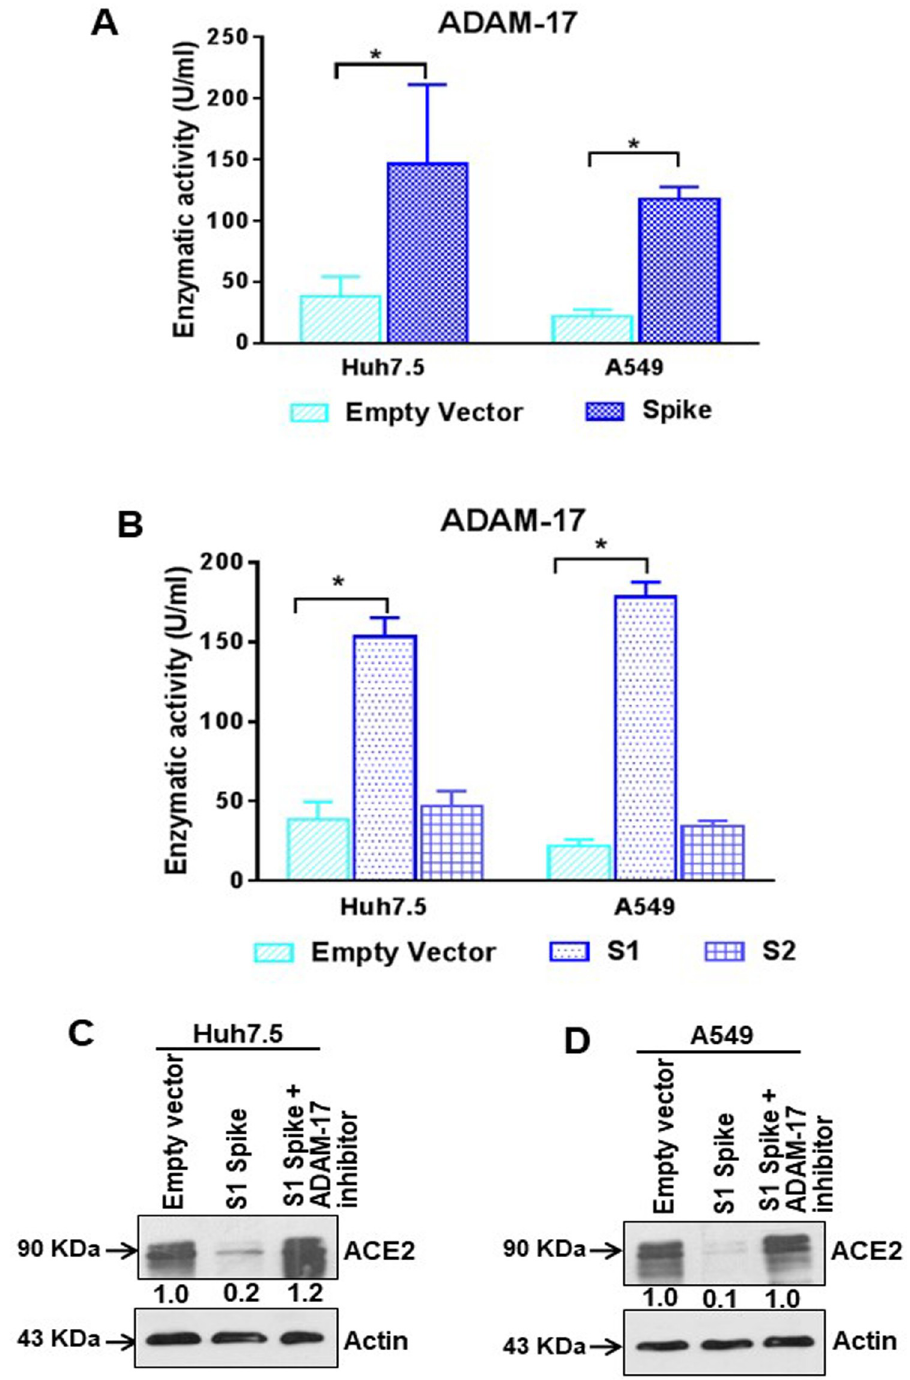
Fig 5. SARS-CoV-2 spike protein regulates ADAM-17 activity. (A) ADAM-17 enzymatic activity was measured from crude extracts of Huh7.5 and A549 cells after transfection of SARS-CoV-2 spike gene constructs. (B) ADAM-17 enzymatic activity was measured from crude extracts of Huh7.5 and A549 cells after transfection of SARS-CoV-2 spike S1 or S2 gene construct or empty vector. The results are presented as mean ± standard deviation. ‘ � ’ represent statistical significance ( p < 0.05). (C, D) Western blot analysis of ACE2 expression in Huh7.5 and A549 cell lysates prepared after 48 h of transfection of empty vector or SARS-CoV-2 spike S1 gene construct in the presence or absence of ADAM-17 inhibitor. Expression level of actin in each lane from same gel is shown as a total protein loading control for comparison.